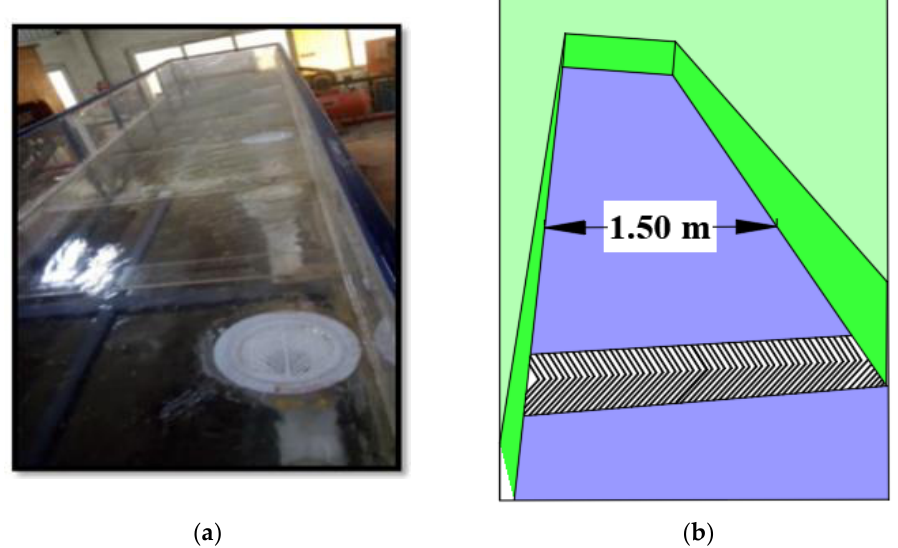
Figure 9. Comparison between grate type 4 in ( a ) the current study ( b ) Manuel study [16]. Table 1. The effect of using different grate shapes on the discharge efficiency.